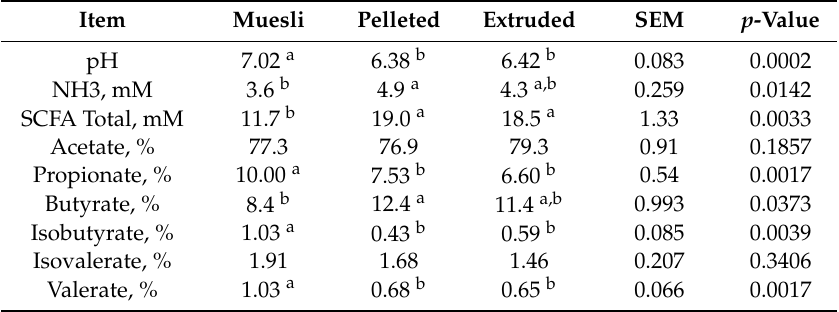
Table 6. Cecal pH, ammonia, and total and individual short chain fatty acids (expressed as molar proportions) from rabbits fed muesli, pelleted or extruded dietary